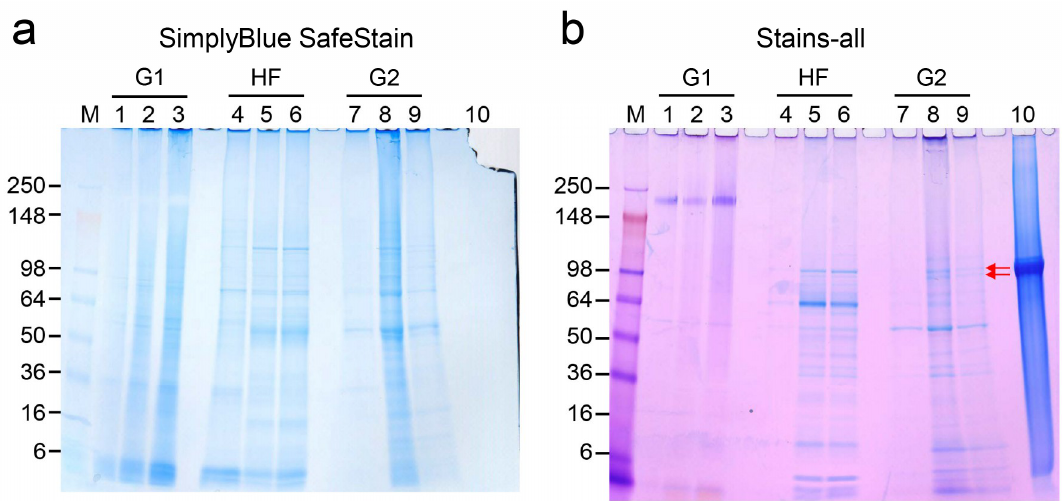
Figure 4. Sequential extraction of proteins from precipitated nodules induced by PPU-7 cells. Precipitated nodules formed in PPU-7 cells cultured in mineralization-inducing culture medium with (MDZ(+)) or without (MDZ(−)) MDZ were sequentially extracted by tris-guanidine (G1 extraction), formic acid–HCl (HF extraction) and tris-guanidine again (G2 extraction). The PPU-7 cells cultured with only standard medium were also extracted as a control. Analysis of the G1, HF, and G2 extracts by 5–20% gradient SDS-PAGE were stained with ( a ) SimplyBlue SafeStain and ( b ) Stains-all stain. Dentin phosphoprotein (DPP) doublet bands in lanes 5, 6, 8, 9, and 10 detected by Stains-all staining are indicated with a red arrow. Lanes 1, 4 and 7: Control; lanes 2, 5 and 8: MDZ(+); lanes 3, 6 and 9: MDZ(-); lane 10: DPP purified from porcine dentin. M: Molecular weight marker (SeeBlue Plus2 Pre-